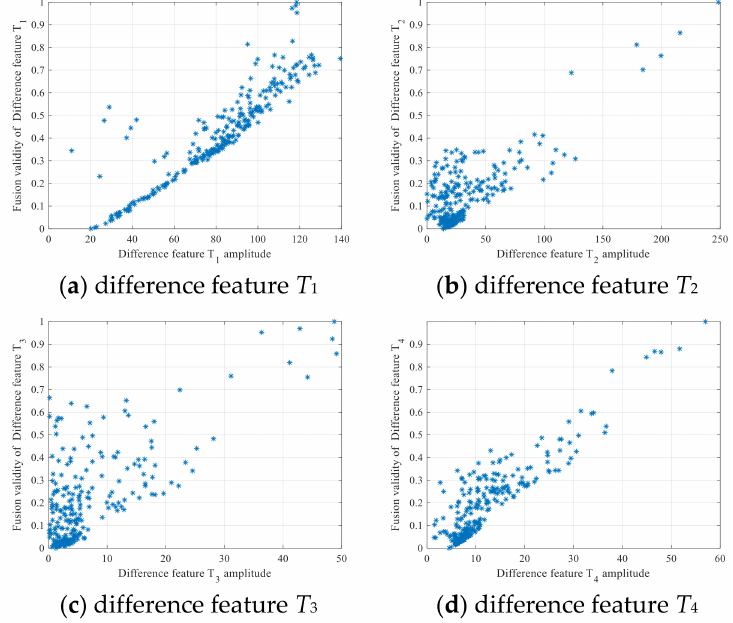
Figure 13. Fusion validity scatterplot of the four difference features. According to the ranking r . j of each fusion algorithm about the value, the optimal fusion algorithm is selected and compared with the selected fusion algorithm of proposed method. The results are shown in Table 7. Table 7. The evaluation index of different fusion algorithms for two group